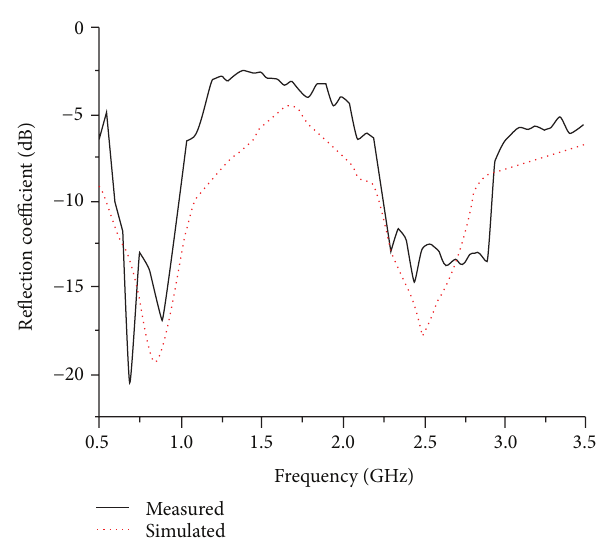
Figure 5: Simulated and measured reflection coefficient of the proposed